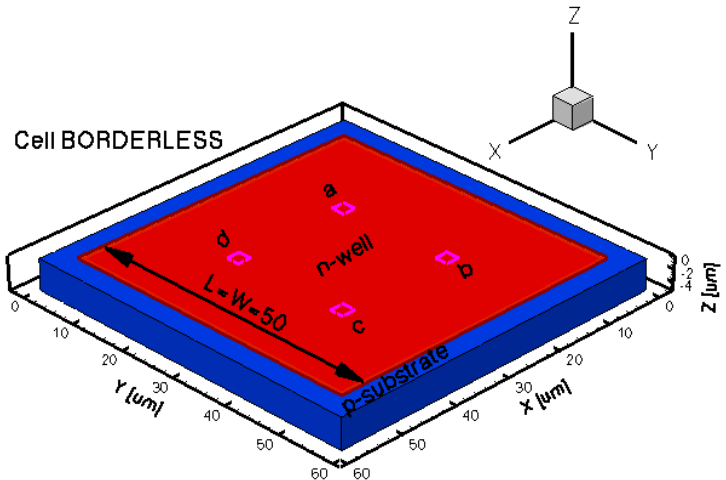
Figure 5. 3D representation of the borderless simulated Hall